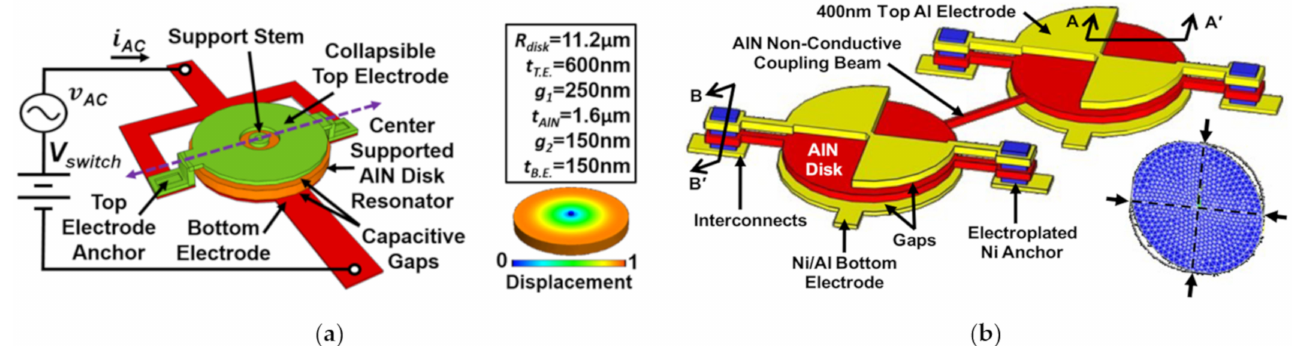
Figure 24. ( a ) Schematic of a 1-DoF capacitive-piezo disk resonator operated at the radial contour mode with the anchor at the center (Reprinted with permission from Ref. [115]); ( b ) Schematic of a 2-DoF capacitive-piezo disk resonator device operated at the WG mode with the anchor connected to the resonator body by a suspension beam (Reprinted with permission from Ref. [114]).